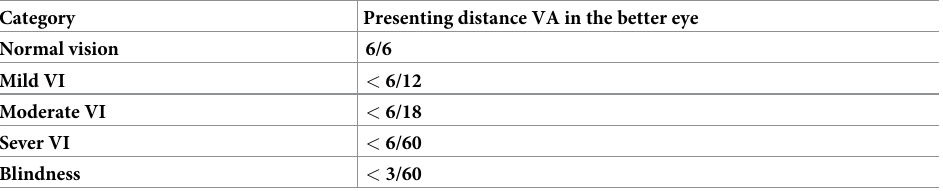
Table 1. Categories of severity of visual impairment according to the International statistical classification of diseases.